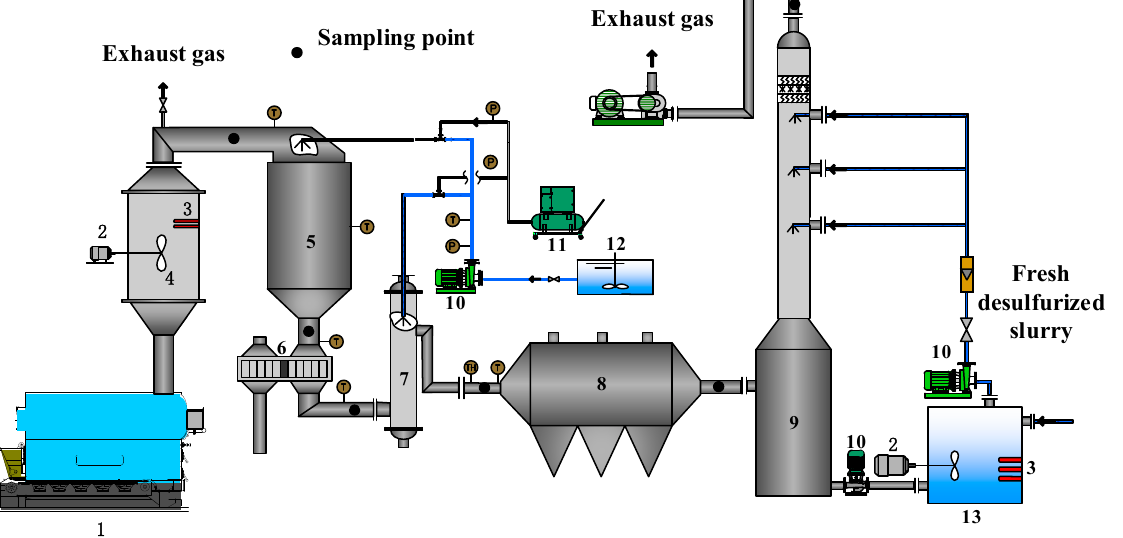
Figure 1. Coal-fired thermal state experimental system. 1—coal-fired boiler; 2—stirring rod; 3—heating rod; 4—buffer tank; 5—SCR; 6—heat exchanger; 7—evaporation chamber; 8—ESP; 9—WFGD; 10—water pump; 11—air compressor; 12—waste water tank; 13—slurry tank.